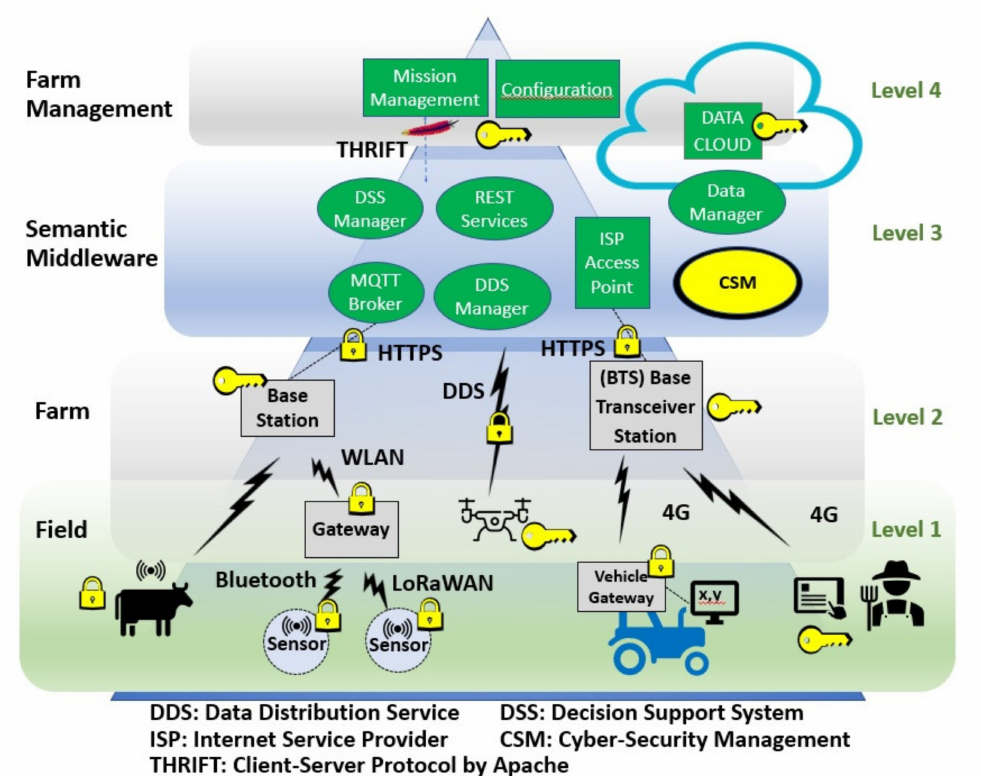
Figure 1. AFarCloud architecture of a future agriculture